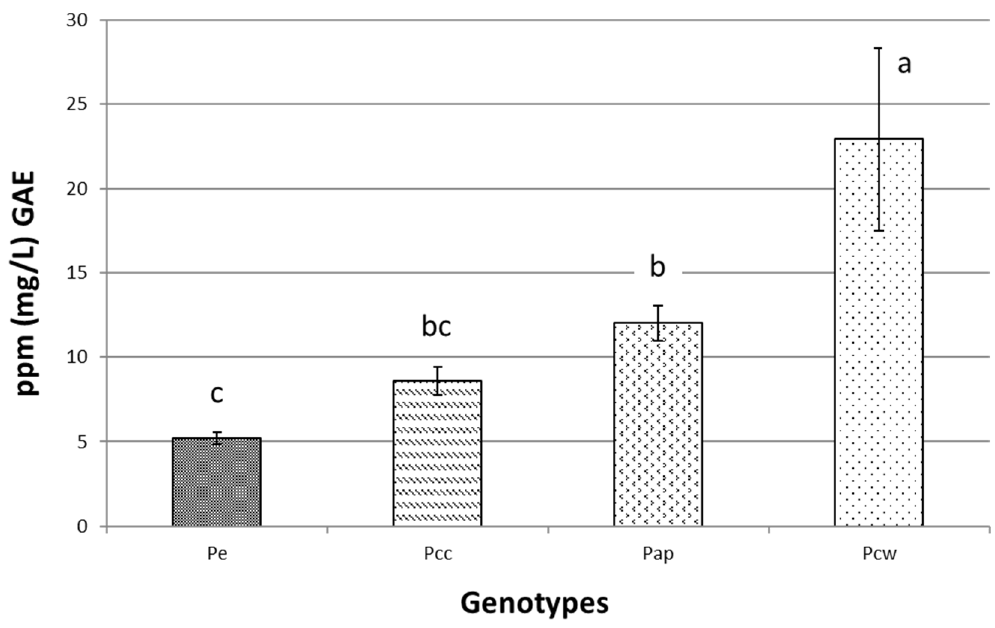
Figure 9. Average phenolic exudation to the medium by roots of plantlets belonging to three inter- specific Pyrus hybrids (Pap, Pcc, Pe) and open pollinated Pyrus communis ‘Williams’ (Pcw), under in vitro iron deficiency conditions. Since no significant interaction was observed between NaHCO 3 and Pyrus species ( p = 0.164) mean values come from the measures of eight replicates per genotype. Bars represent the standard error. Hybrids with different letter are significantly different (Tukey, p < 0.05).